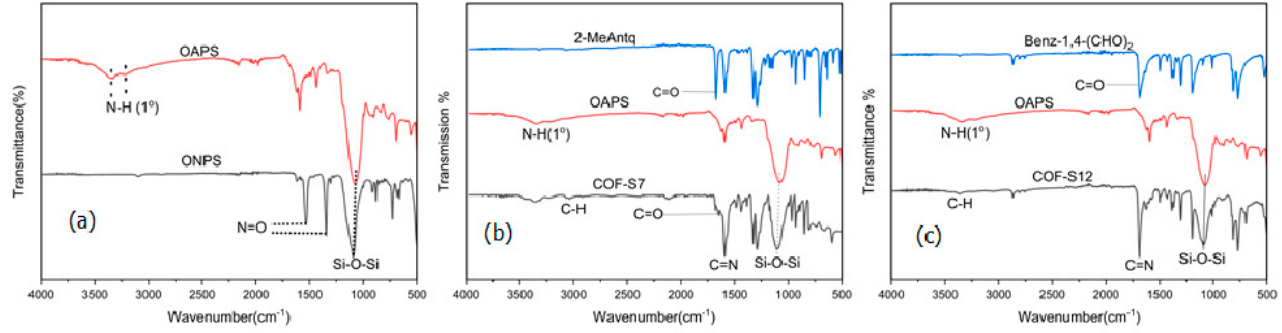
Figure 2. PXRD spectra of as-synthesized COFs with different solvents for chemical stability study ( a ) COF-S7 and ( b ) COF-S12.